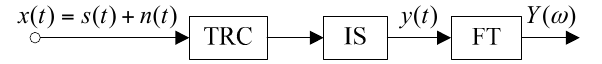
Figure 8. Normalized outputs of the MF, the FDAMF, and the TRC-IS-FDAMF when the input SNR = − 15 dB. ( a ) The MF (SNR = 13.3 dB); ( b ) The FDAMF (SNR = 19.5 dB); ( c ) The TRC-IS-FDAMF (SNR = 46.8 dB).